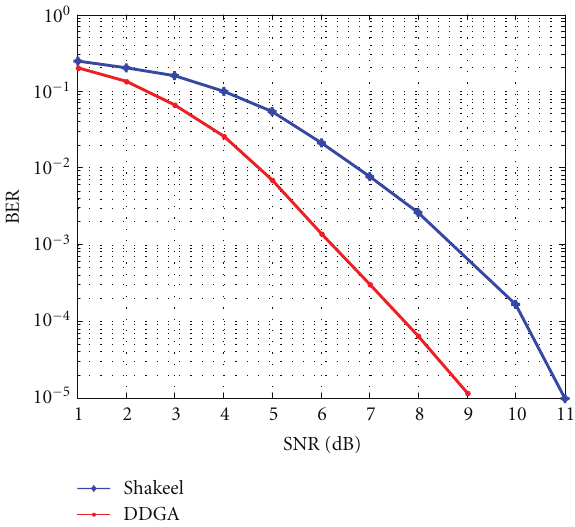
Figure 28: Performances of DDGA, and Shakeel algorithms for BCH (127,64,21) code over RC.